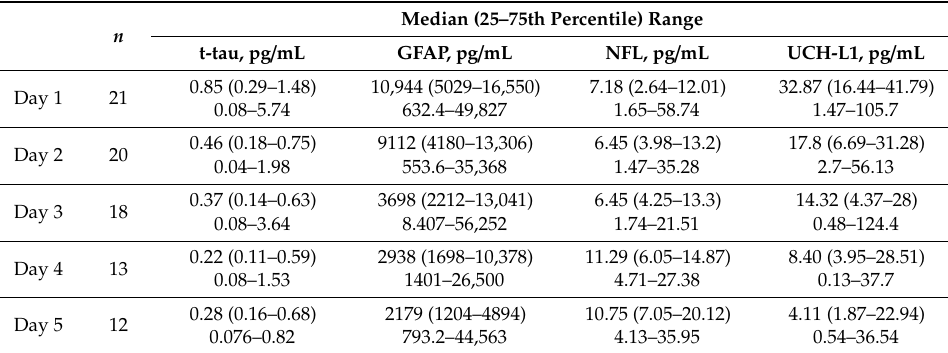
Figure 1. Box and whisker plots of the median concentrations of serum exosomal ( A ) total-tau (t-tau), ( B ) glial fibrillary acidic protein (GFAP), ( C ) neurofilament light chain (NFL), and ( D ) ubiquitin carboxy-terminal hydrolase L1 (UCH-L1) over time study. The upper and lower bounds of each box indicate the 75th and 25th percentiles, respectively. Within each box, the horizontal line indicates the median. Whiskers extend to 1.5 × IQR. Significant differences are indicated with * p < 0.05, ** p < 0.01, *** p < 0.001 vs. day 1; ## p < 0.001 vs. day 2. For masking purposes, the displayed y -axis range for exosomal t-tau is 0–2.5 pg / mL (two outliers on day 1, and one on day 3 (not shown)), for exosomal GFAP is 0–40,000 pg / mL (one outlier on day 1, 3, and 5 (not shown)), and for exosomal NFL is 0–50 pg / mL (one outlier on day 1 (not shown)). Table 2. Exosomal concentrations of t-tau, GFAP, NFL, and UCH-L1 for